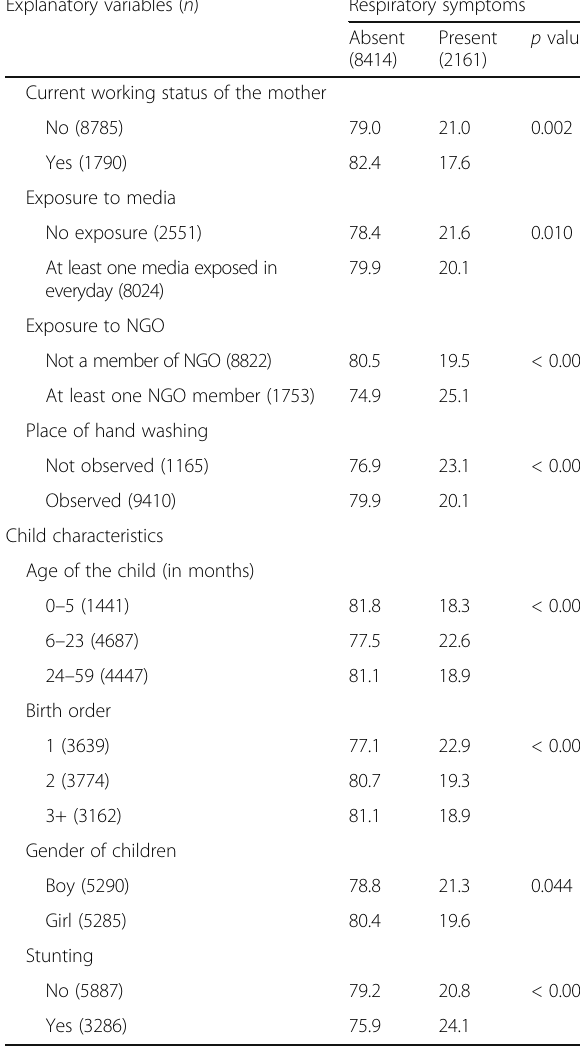
Table 2 Association between respiratory symptoms of the children and use of biomass fuel, residential factors, and mother and child characteristics